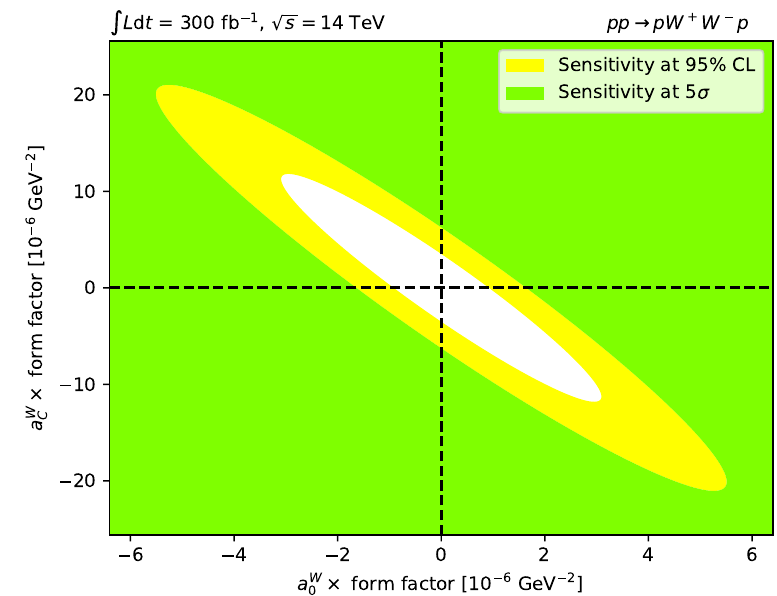
Figure 12 . Projected sensitivities on the anomalous coupling parameters a W form factor with cutoff energy of Λ cutoff = 2 TeV. The projections are shown for pp → pW + W − p at 14 TeV assuming an integrated luminosity of 300 fb − 1 . The yellow and green areas represent the projected sensitivities at 95% CL and 5 σ , respectively. The results correspond to a combination of hadronic, semi-leptonic, and leptonic decay channels of the W + W − system. The blank area in the center represents the region where we do not expect sensitivity to the anomalous coupling parameter. Time-of-flight measurements with 20 ps precision is